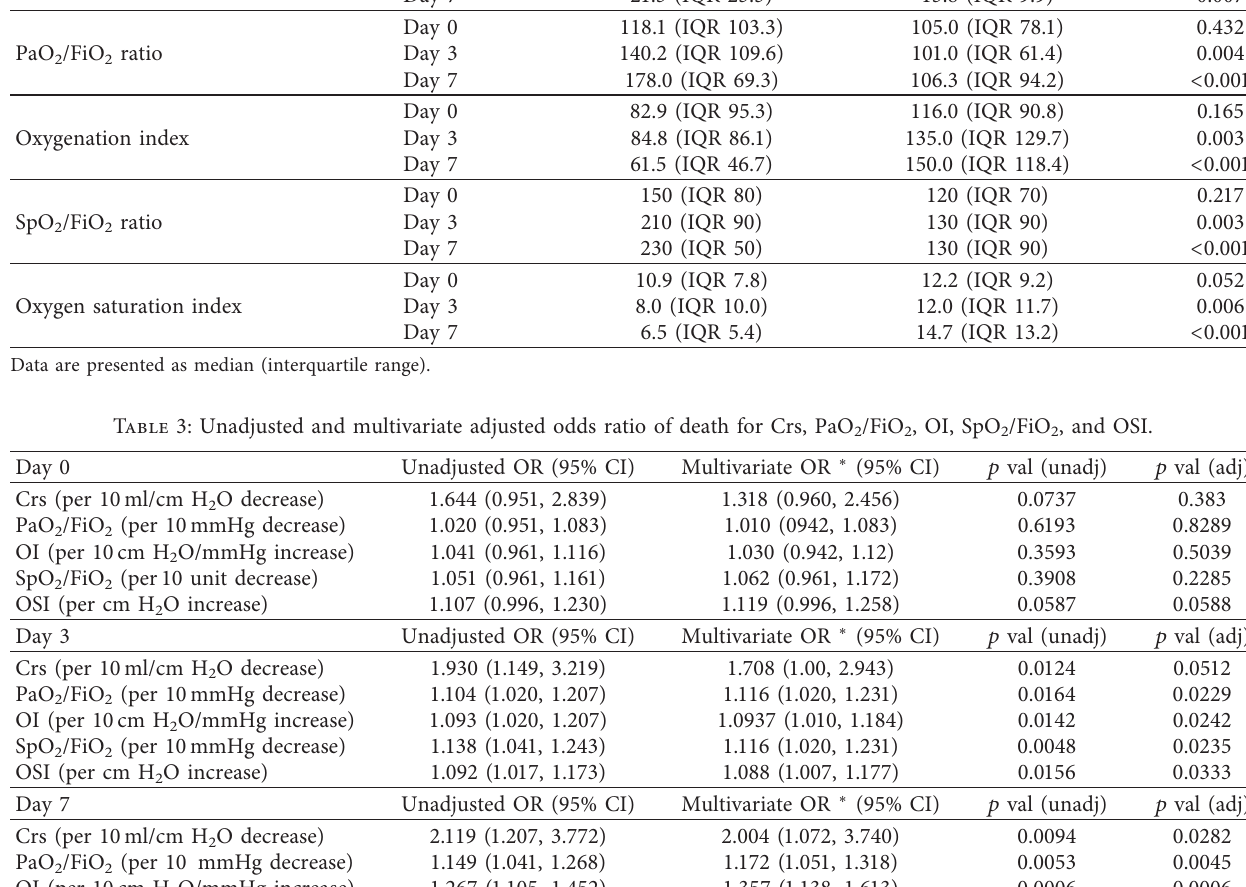
Table 2: ARDS severity indices for COVID-19 survivors and nonsurvivors on days 0, 3, and 7 after intubation.